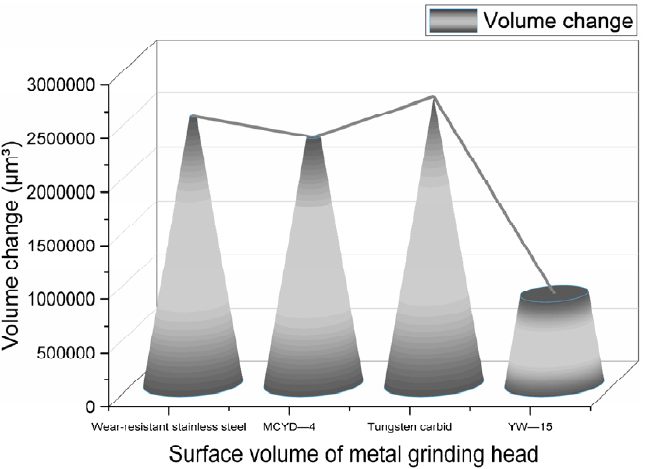
Figure 14. Metal wear volume without spraying high temperature ethanol–water vapor mixture. The abrasive wear and corrosion wear of metal can be calculated by comparing the wear measured in the experiment with that measured by spraying a high-temperature ethanol–water vapor mixture. To ensure the accuracy of the experiments, six repeated experiments were carried out, and the average value was calculated. The proportion of the two wear forms is shown in Figure